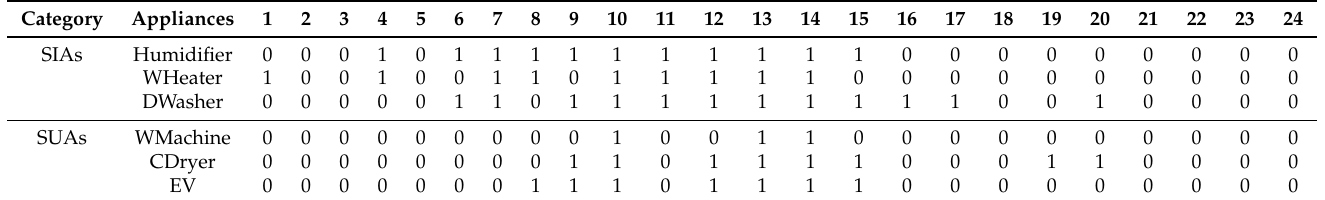
Figure 8. Estimated renewable energy. Table 4. Consumer schedules without participating in a DR program.